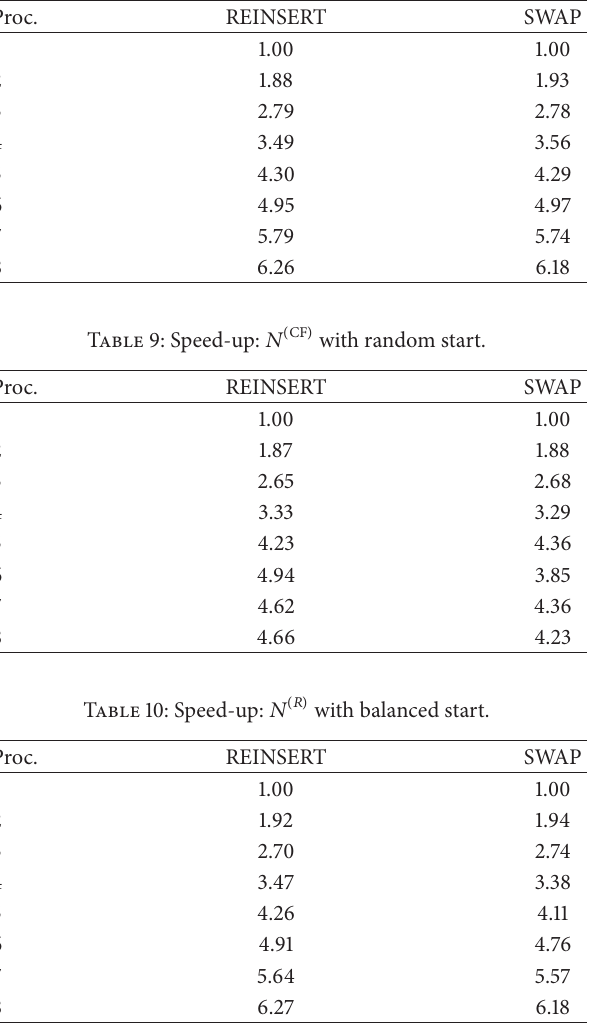
Table 8: Speed-up: 𝑁 ( CF ) with balanced start. Proc.